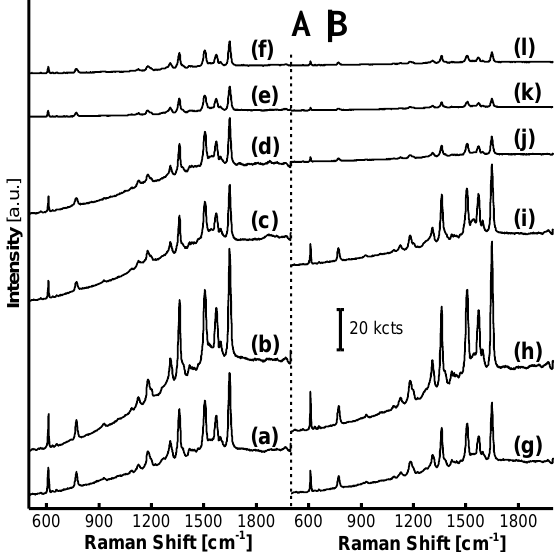
Figure 6. SERRS spectra of AgNP/MF 6 vs. the acidity and treatment number in the MF 6 acid-treatment reaction: ( a ) pH 4.0, ( b ) 3.7, ( c ) 3.3, ( d ) 3.0, ( e ) 2.7 and ( f ) 2.3 in ( A ) were collected on the sub-